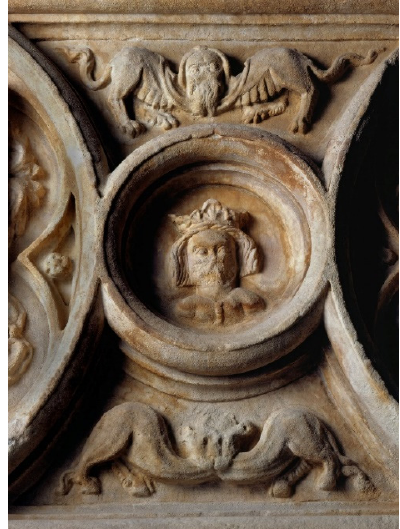
Figure 6. Bust of King Fernando I on the cover of his tomb. 1380–1383. From Santarem, currently at the